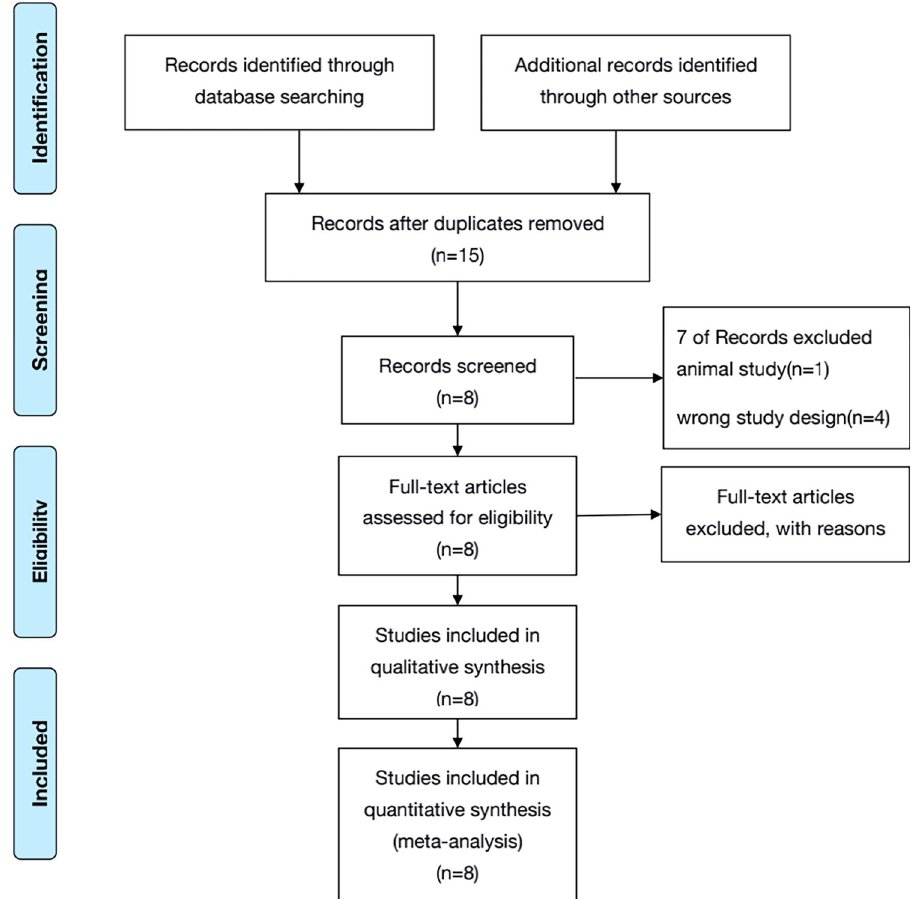
Fig 1. Flow chart of study selection